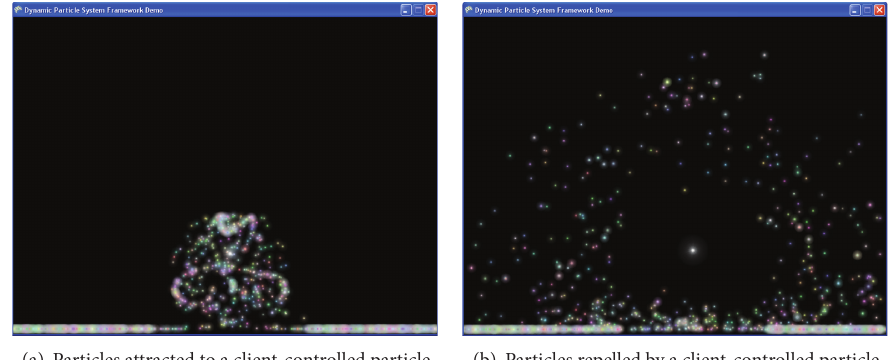
Figure 6: Particles being attracted to and repelled away from a client-controlled particle.